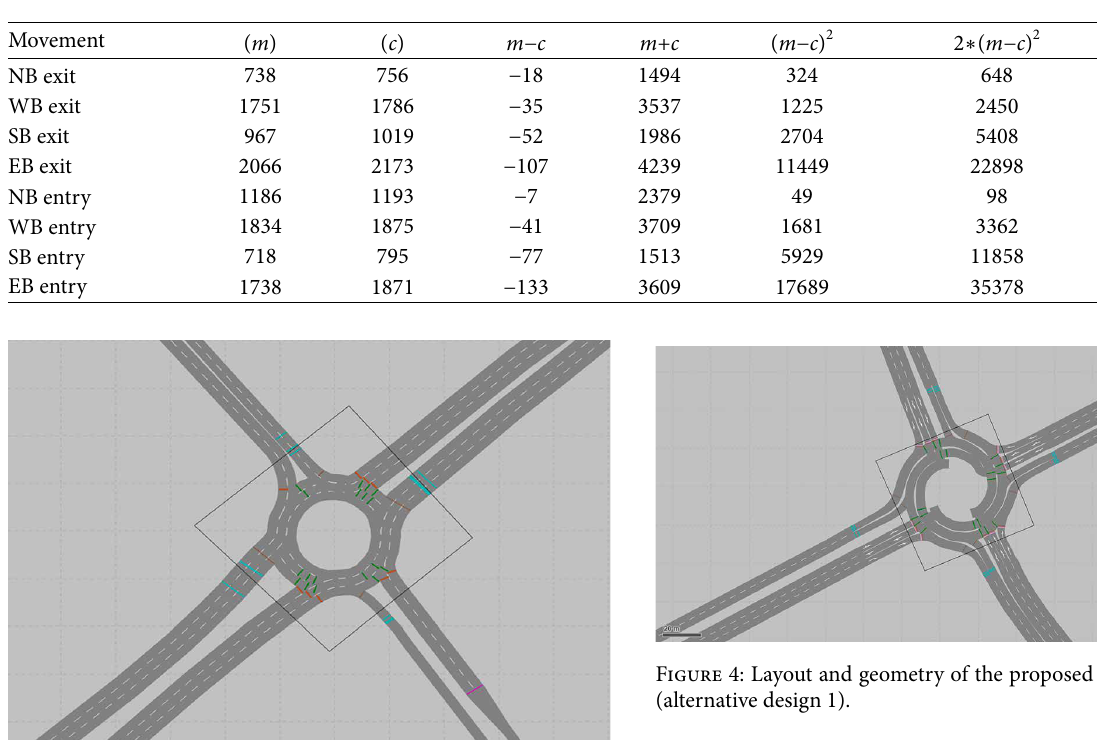
Table 6: GEH statistic calculations for validation’s model.